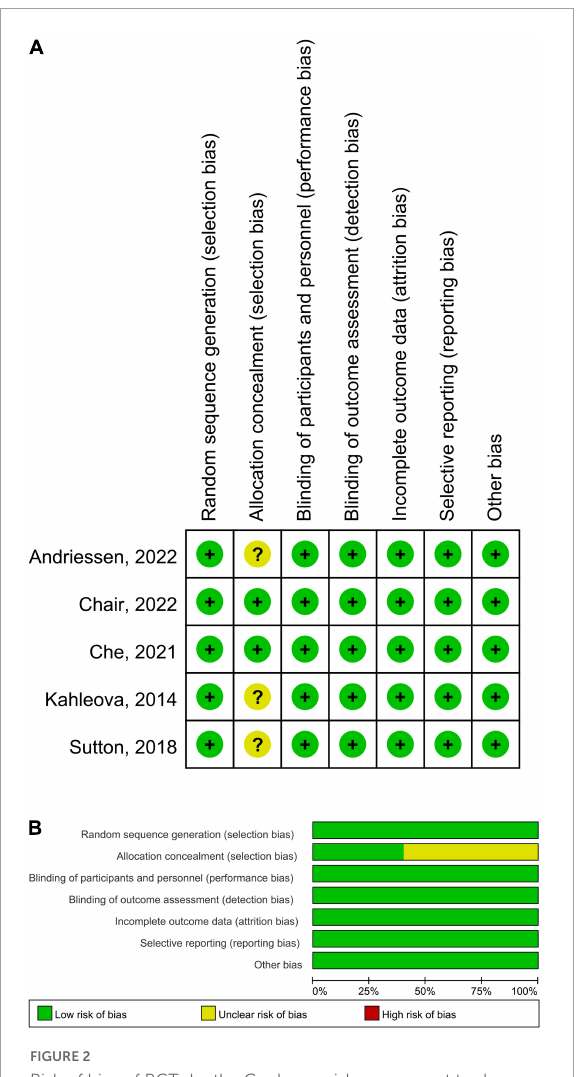
and improve measures of glycemic control significantly.